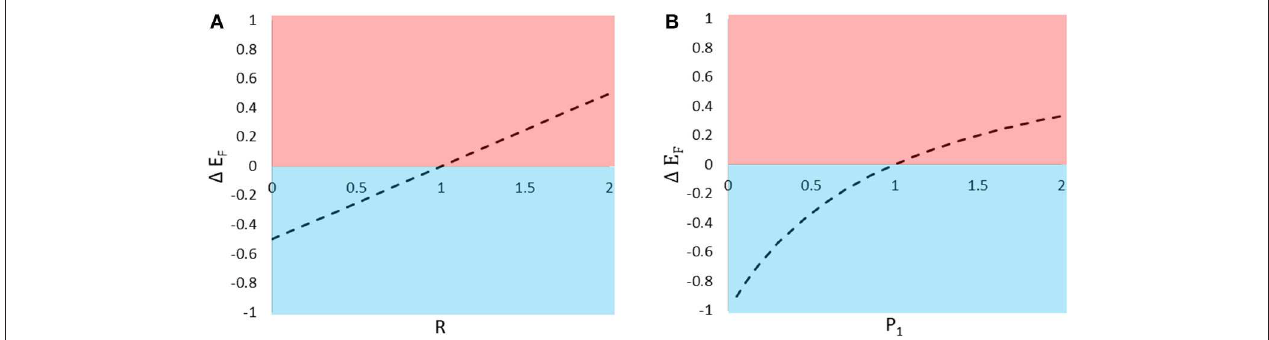
FIGURE 2 | The predicted change in eavesdropper pressure ( 1 E F ) on an individual signaler resulting from the introduction of a neighboring individual. The change in eavesdropper pressure is predicted to vary with (A) the relative attractiveness of the two types of prey to distant enemies and (B) the enemy’s relative preference for the two types of prey. Values of 1 E F > 0 indicate that the presence of the neighbor inflicts collateral damage on the focal individual (pink shading), and 1 E F < 0 indicate that the neighbor casts a shadow of safety on the focal signaler (blue